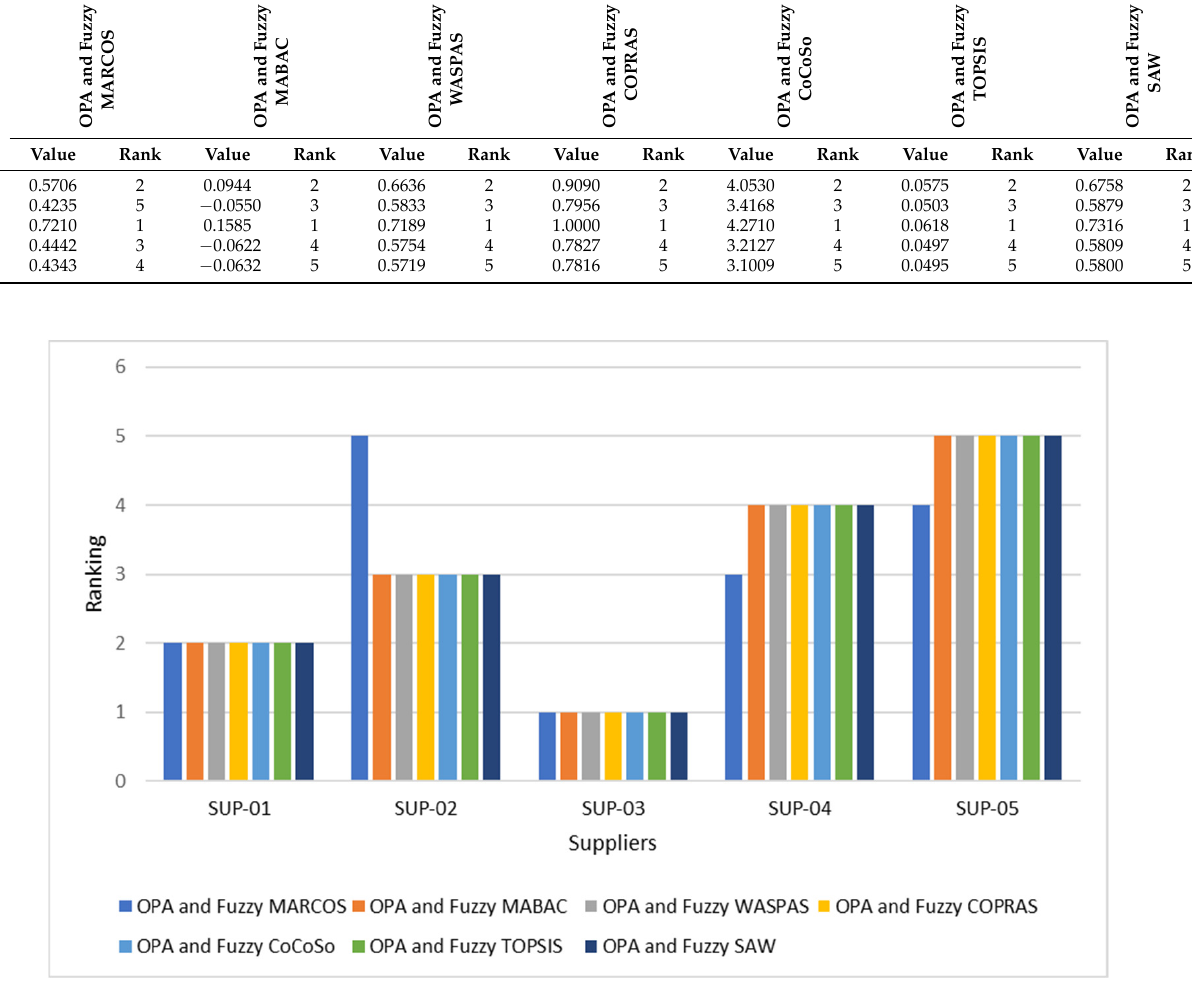
Figure 6. Comparison of OPA–fuzzy MARCOS with other MCDM methods.